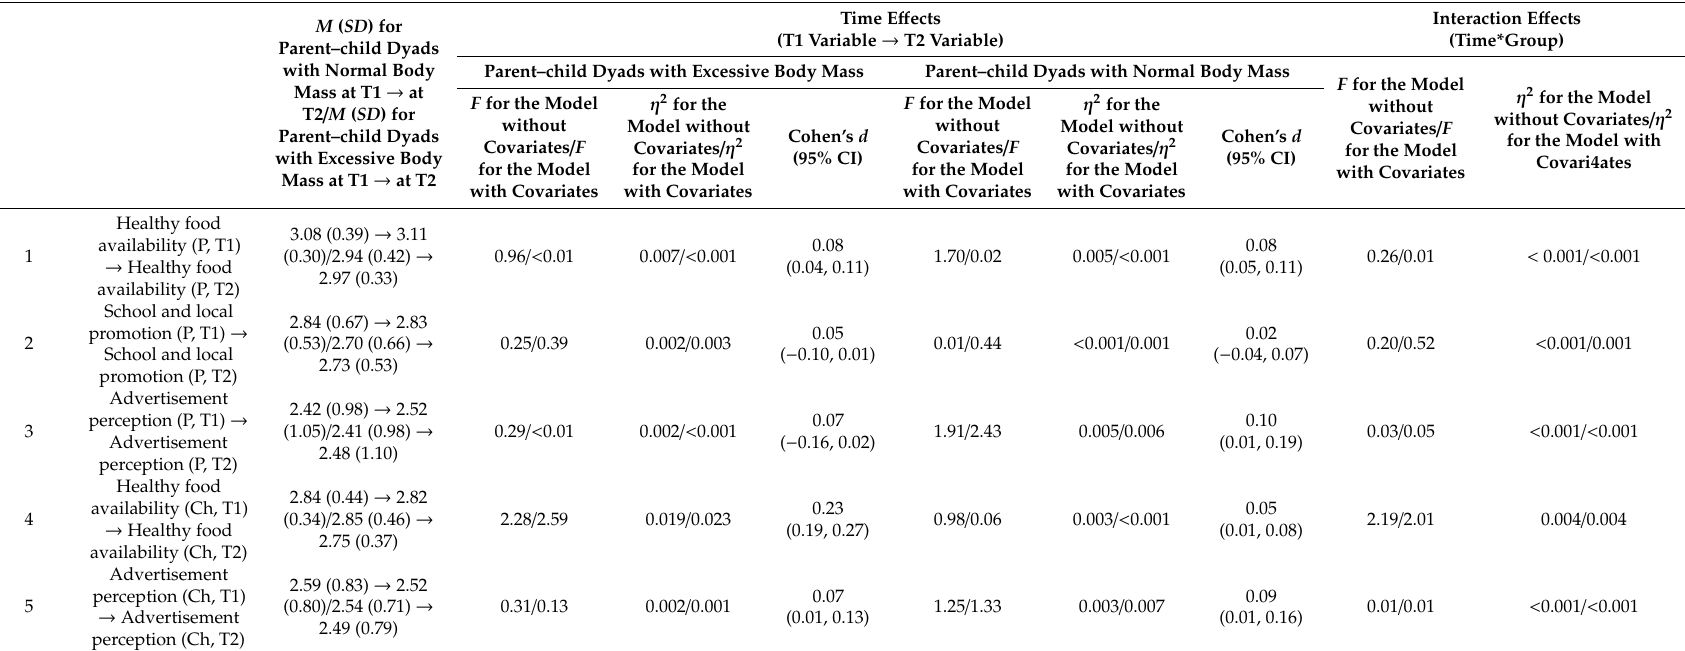
Table A3. Di ff erences in perceptions of at-home and out-of-home environment: Parent–child dyads with excessive body mass ( n = 129) versus parent–child dyads with normal body mass ( n =